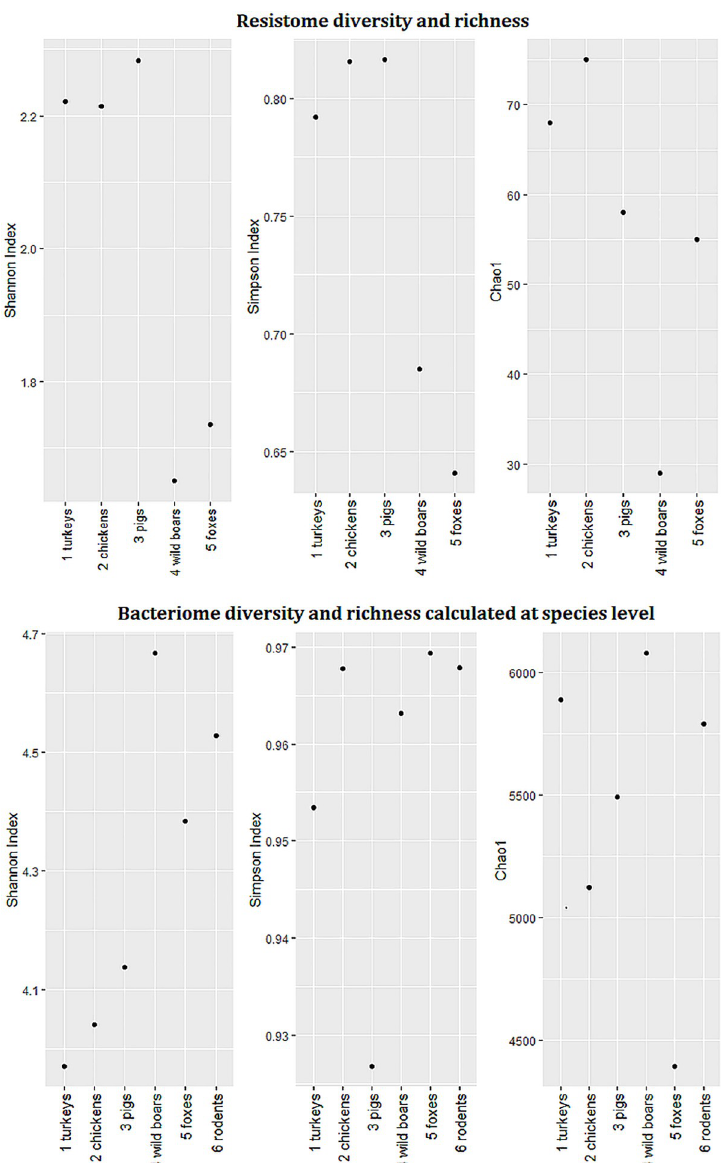
Fig 2. Resistome and bacteriome diversity and richness. Shannon, Simpson diversity indexes and Chao1- richness calculated from the read counts.